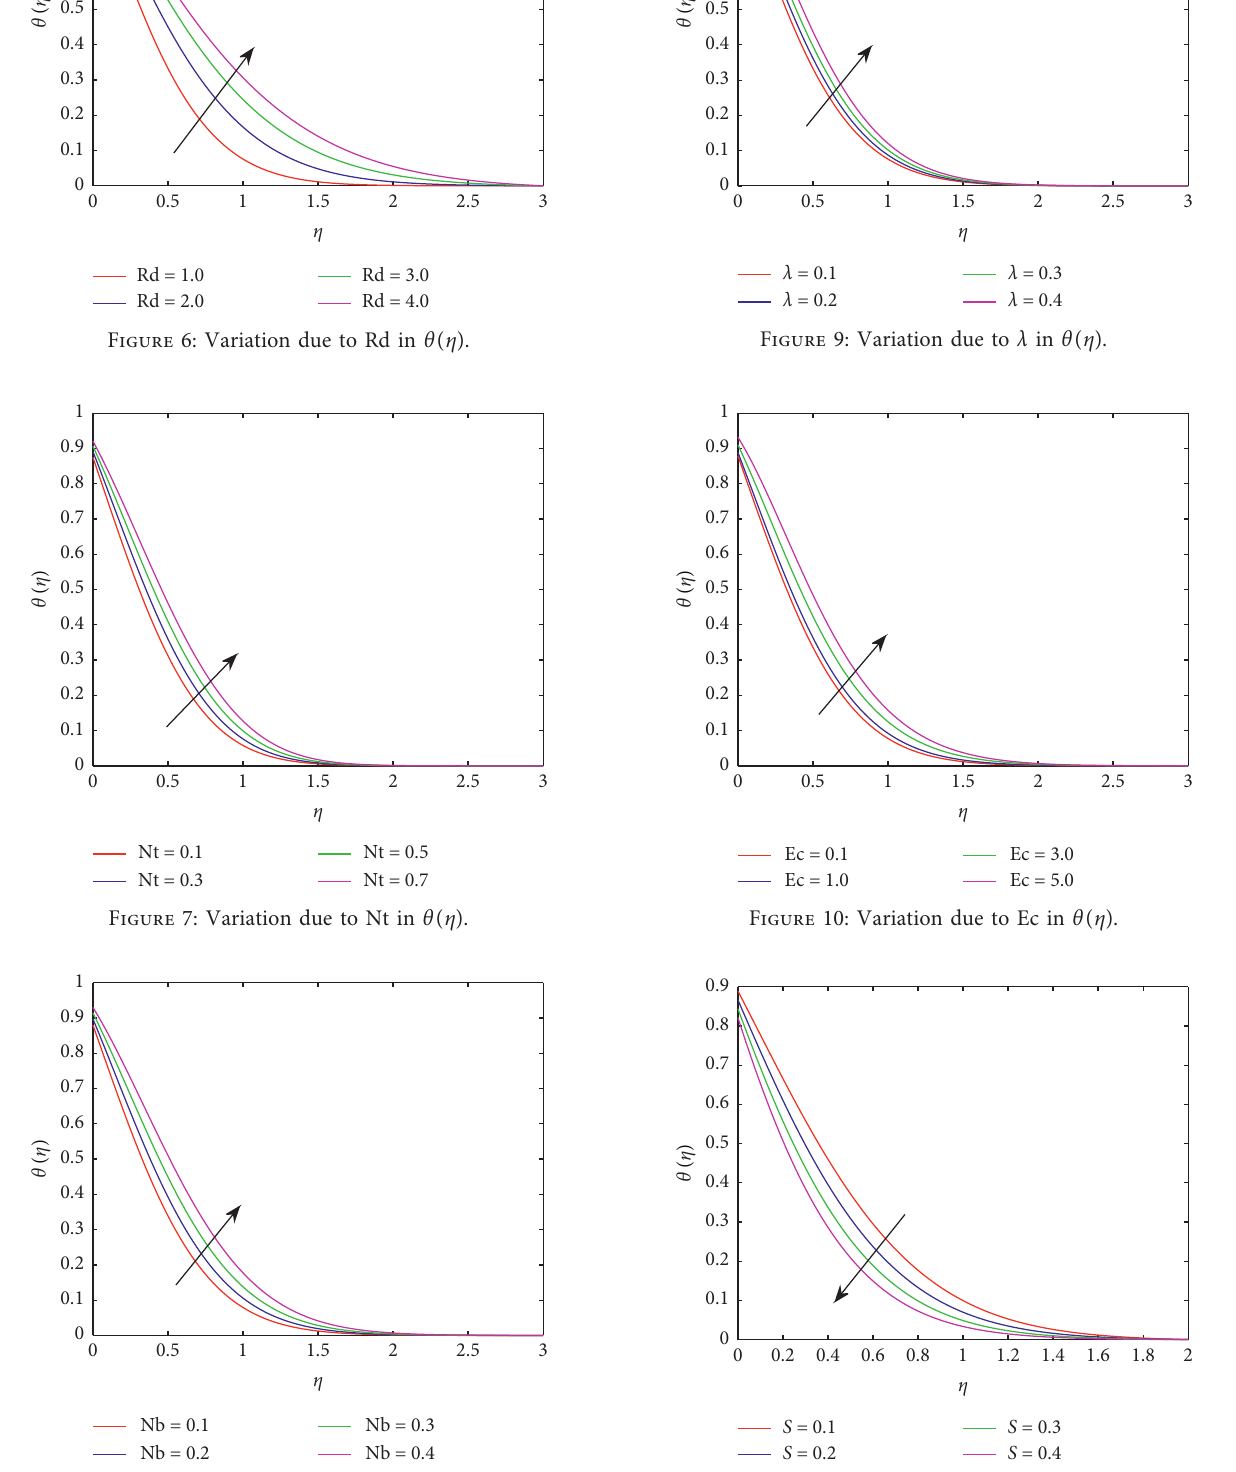
Figure 8: Variation due to Nb in θ ( η ) . Figure 11: Variation due to S in θ ( η ) .